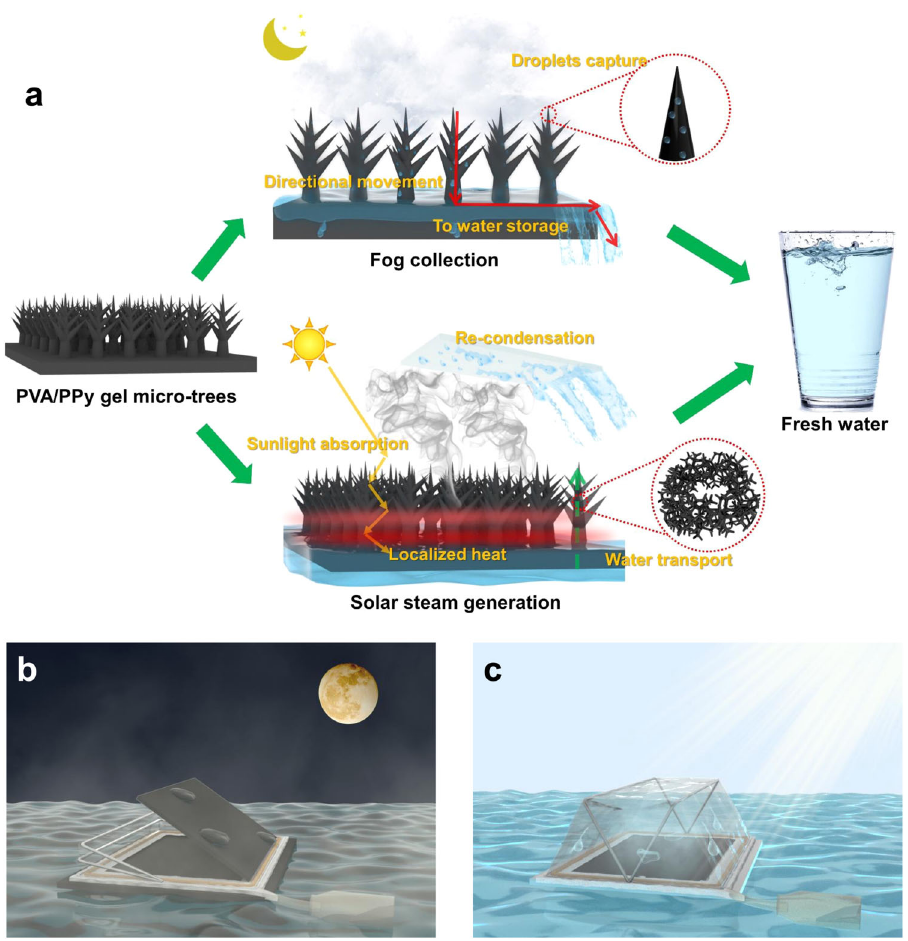
Fig. 1 Design of the bifunctional gel membranes and all-day water harvesting prototype. a Conceptual representation of the PVA/PPy hydrogel membrane with micro-topologies that is capable of 24-h fresh water harvesting. b , c Schematic illustration of nighttime ( b ) and daytime ( c ) modes of fl oating device for all-day water